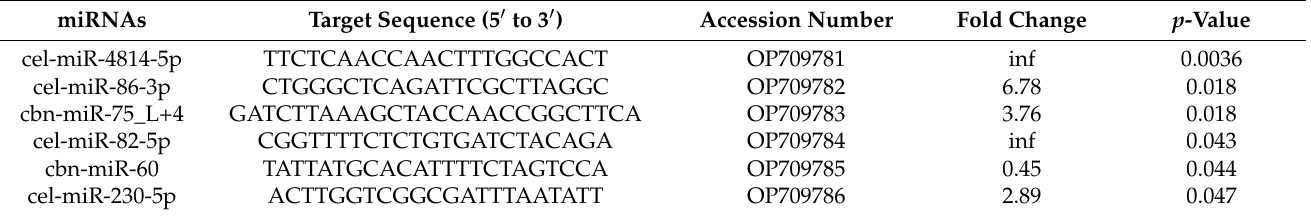
Table 3. The differentially expressed miRNA in C. elegans treated with astaxanthin. miRNAs Target Sequence (5 (cid:48) to 3 (cid:48) ) Accession Number Fold Change p